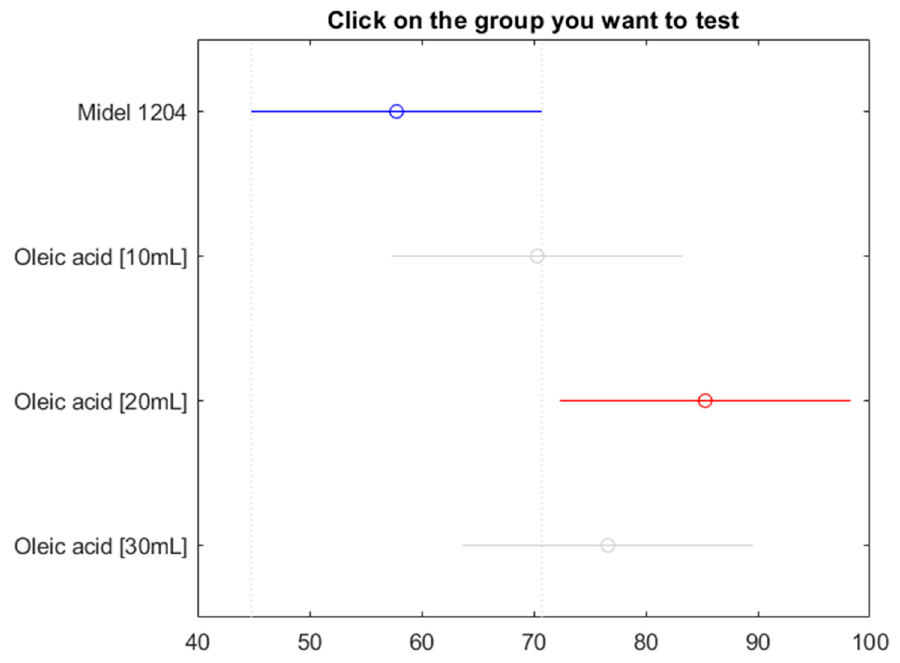
Figure 20. Post hoc Bonferroni test for oil Midel 1204, with different concentrations of surfactant oleic acid. In Table 11, all of the results of the Kruskal–Wallis test comparison were listed. From there, we can read comparisons between all samples: their lower and upper limits, differ- ences, and probabilities. Table 11. Multiple comparison results of the Kruskal–Wallis test between all samples.